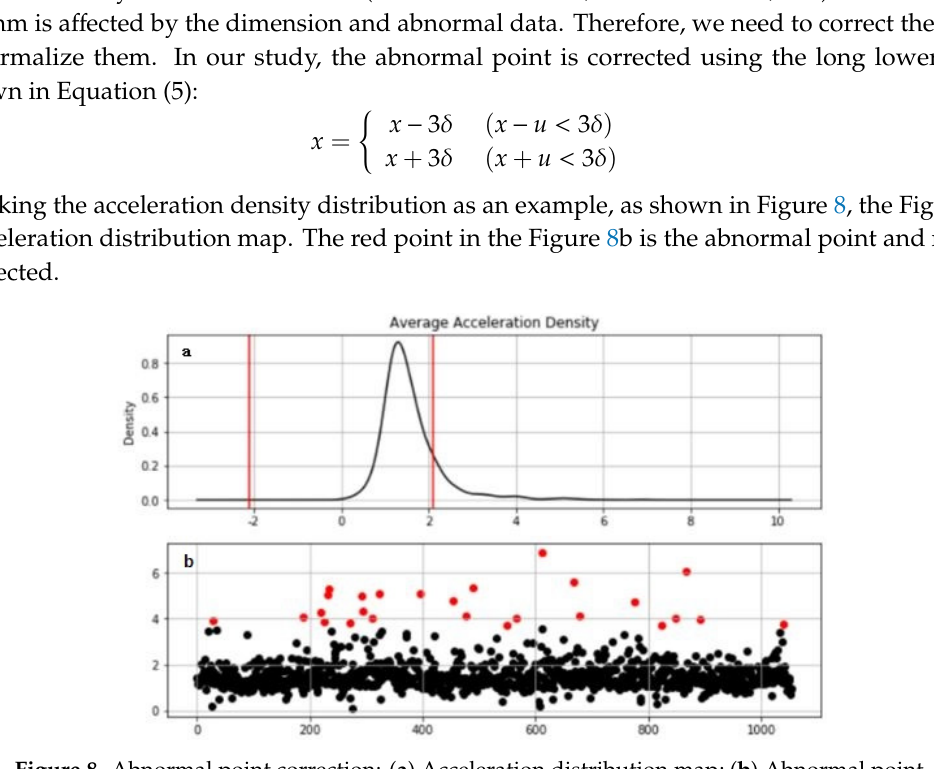
Figure 9. Abnormal point correction: ( a ) Comparison results before; ( b ) Comparison results after. 5.3. Feature Dimension Reduction